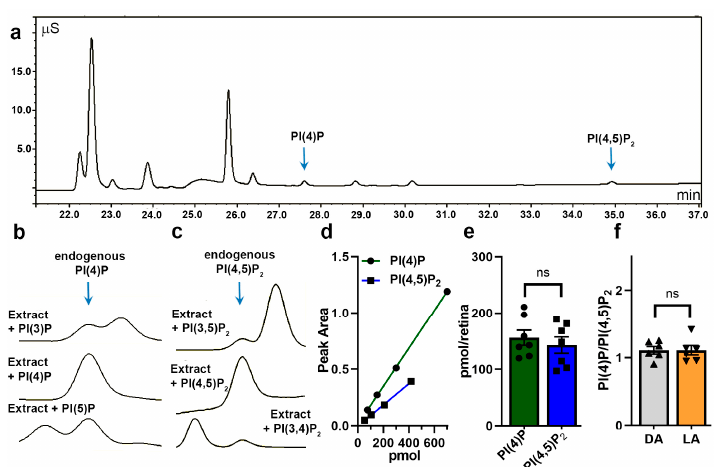
Figure 1. PI(4)P and PI(4,5)P 2 are the major phosphorylated phosphoinositides in the mouse retina. ( a ) Representative chromatogram of headgroups from delipidated phosphoinositides extracted from the mouse retina, separated by anion-exchange HPLC and monitored by suppressed conductivity detection. ( b , c ) Chromatograms of delipidated headgroups obtained from mouse retinal extracts separated in the presence of di ff erent delipidated phosphorylated phosphoinositide standards. PI(4) ( b ) and PI(4,5)P 2 ( c ) are major phosphorylated inositide headgroups in the retina. ( d ) Calibration curves for headgroups from delipidated PI(4)P and PI(4,5)P 2 standards are linear in the range 50-800 pmol (n = 3; error bars are not plotted due to SD values being smaller than symbol sizes). ( e ) The retina contains comparable amounts of PI(4)P and PI(4,5)P 2 (~150 pmol; p = 0.52). ( f ) The PI(4)P to PI(4,5)P 2 ratio in the